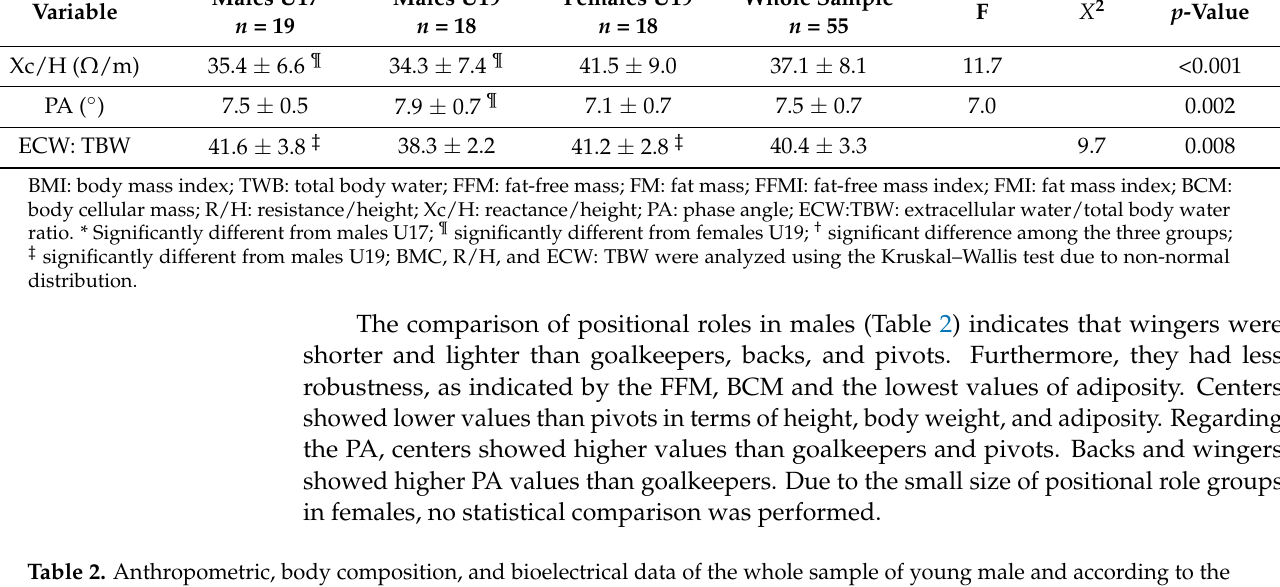
Table 2. Anthropometric, body composition, and bioelectrical data of the whole sample of young male and according to the positional roles.